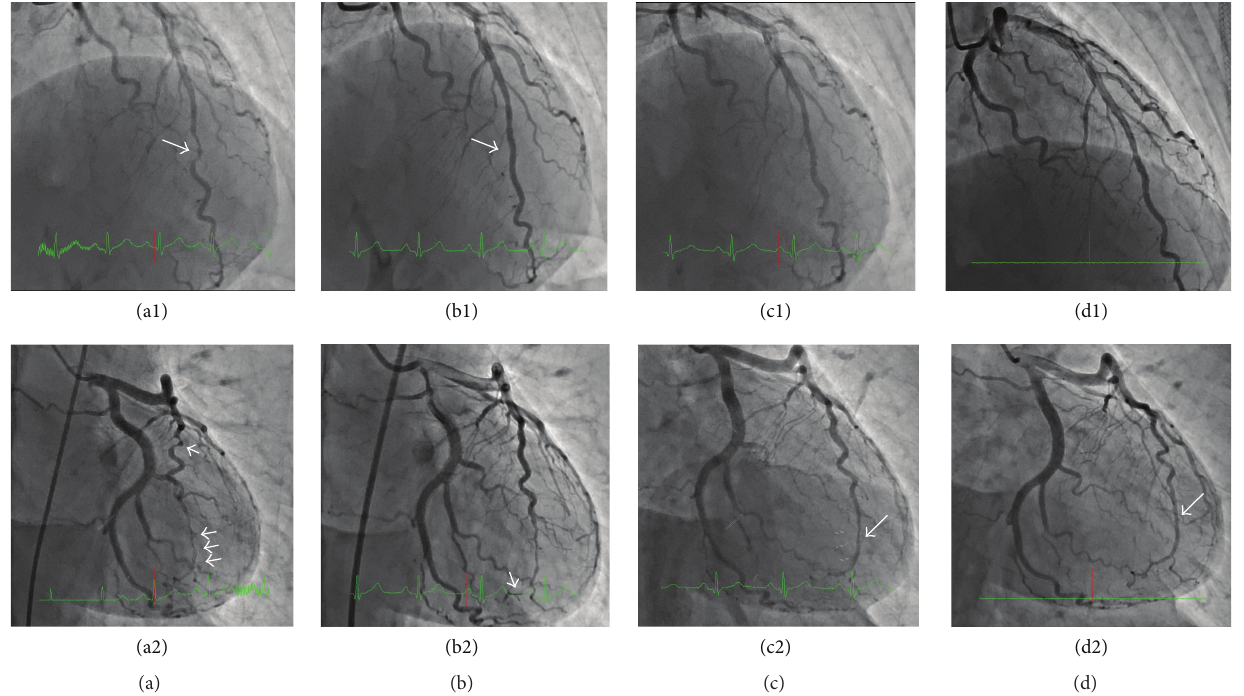
Figure 2: Time course of a coronary angiogram of the left coronary artery (LCA). (a) MI onset; (b) after implantation of a zotarolimus-eluting stent in the mid LAD; (c) 12 days after the onset of the MI; (d) 6 months after the onset of the MI. 1: RAO cranial view; 2: straight caudal